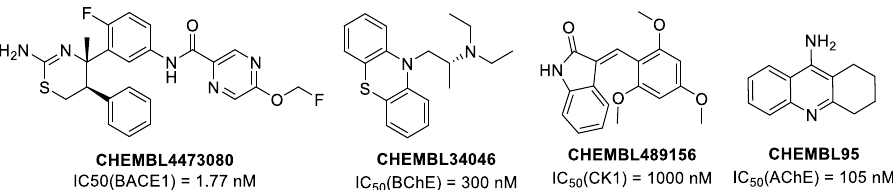
Figure 3. Examples of inhibitors of BACE1 (CHEMBL4473080, PDB: 6jse), BChE (CHEMBL34046, PDB: 6eqp), CK1 δ (CHEMBL489156, PDB: 1eh4), AChE (CHEMBL95, PDB: 7e3i).